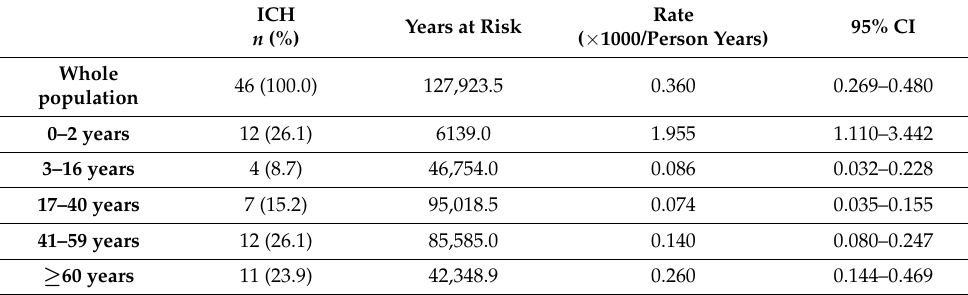
Table 2. Intracranial haemorrhage (ICH) incidence in the different age groups.